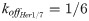
Modelling Notch signalling’s ability to combat increasing levels of stochasticity.In each case we plot the mean Her1 protein levels for 64 cells to illustrate how synchronous the clock oscillations are. Notch signalling is active in each case. 6A: Dissociation parameter, koffHer1/7=1/6 min-1. Notch signalling can cope with double the magnitude of stochasticity. 6B: Dissociation parameter, koffHer1/7=1/15 min-1. Notch signalling begins to struggle to keep neighbouring cells oscillating in synchrony. 6C: Dissociation parameter, koffHer1/7=1/30 min-1. Notch signalling is not strong enough to counteract the levels of stochasticity in her1/7 gene regulation. Neighbouring cells quickly desynchronise oscillation. 6D: Dissociation parameter, koffHer1/7=1/30 min-1 while delay (transcription and translation delays and delay in activation of Notch) has been increased threefold. Neighbouring cells once again oscillate in synchrony, but with longer period. As the levels of stochasticity in her1/7 gene regulation increase, Notch signalling is no longer able to override stochastic effects and keep neighbouring cells oscillating in synchrony. To rescue synchrony, further changes to the system are required, for example, by increasing the magnitude of delay.